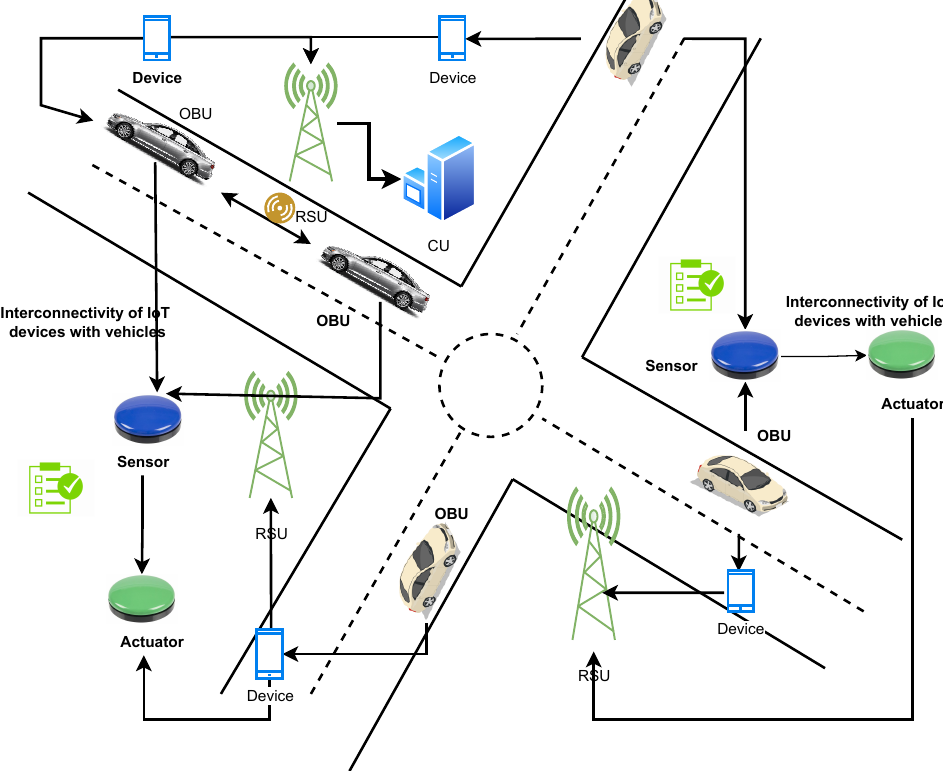
Figure 5. Proposed model with V2I